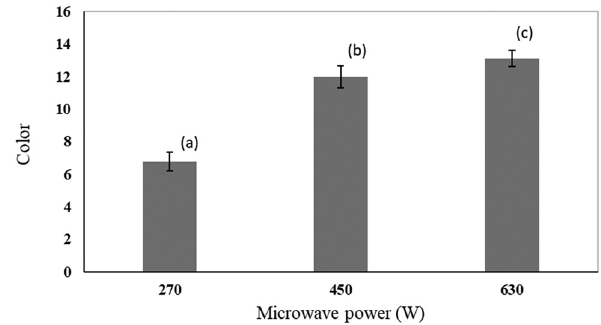
Figure 9: Colour change of dried pomegranate arils in MW dryer. The bars represent mean values and the corresponding standard deviations. Bars with the same letter are not signi fi cantly di ff erent according to ANOVA and Tukey test ( p < 0.05 )